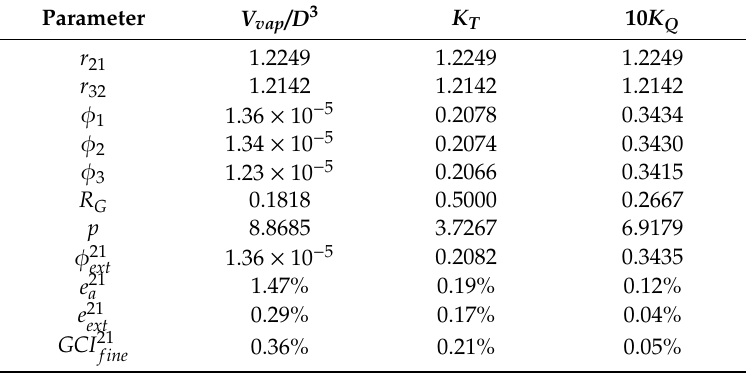
Table 3. Discretization errors with regard to V vap / D 3 , K T and 10 K Q